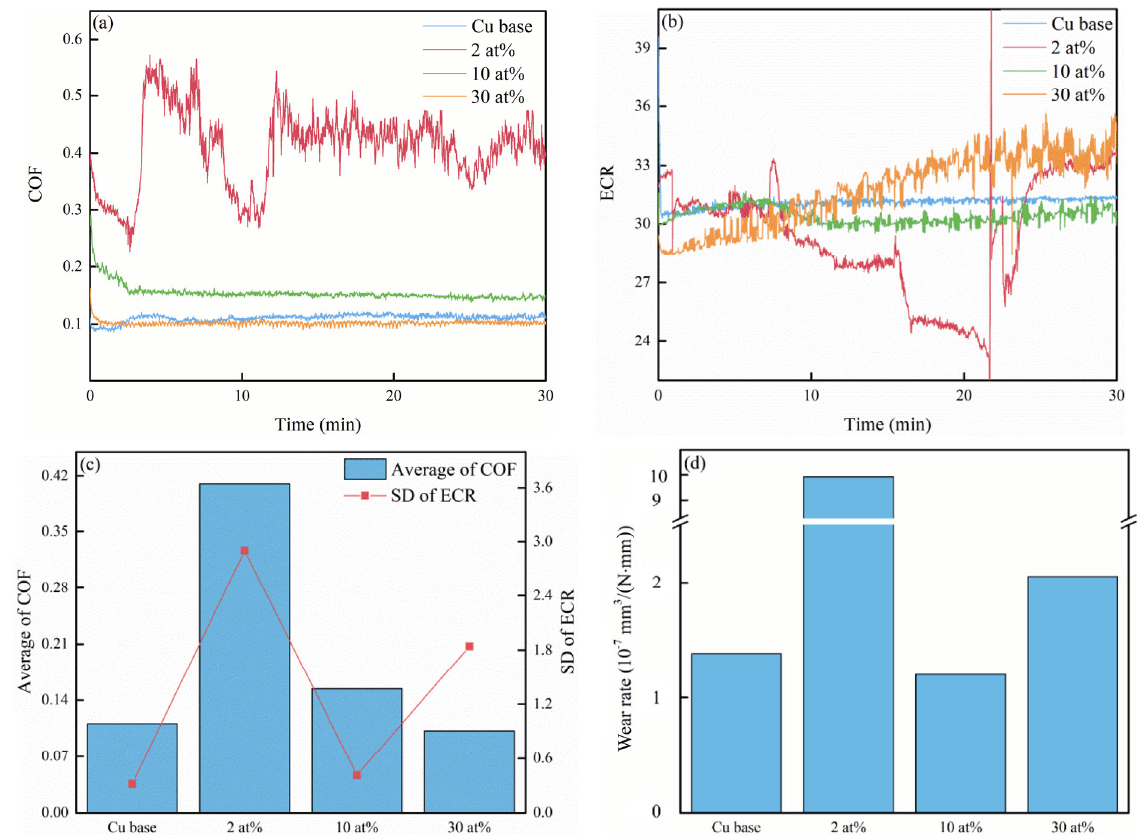
Fig. 5 Evolution of (a) COF, (b) ECR for Cu base and TiN–Ag coating samples, (c) average of COF and SD of ECR, and (d) wear rate under grease (voltage: 0.5 V; load:15